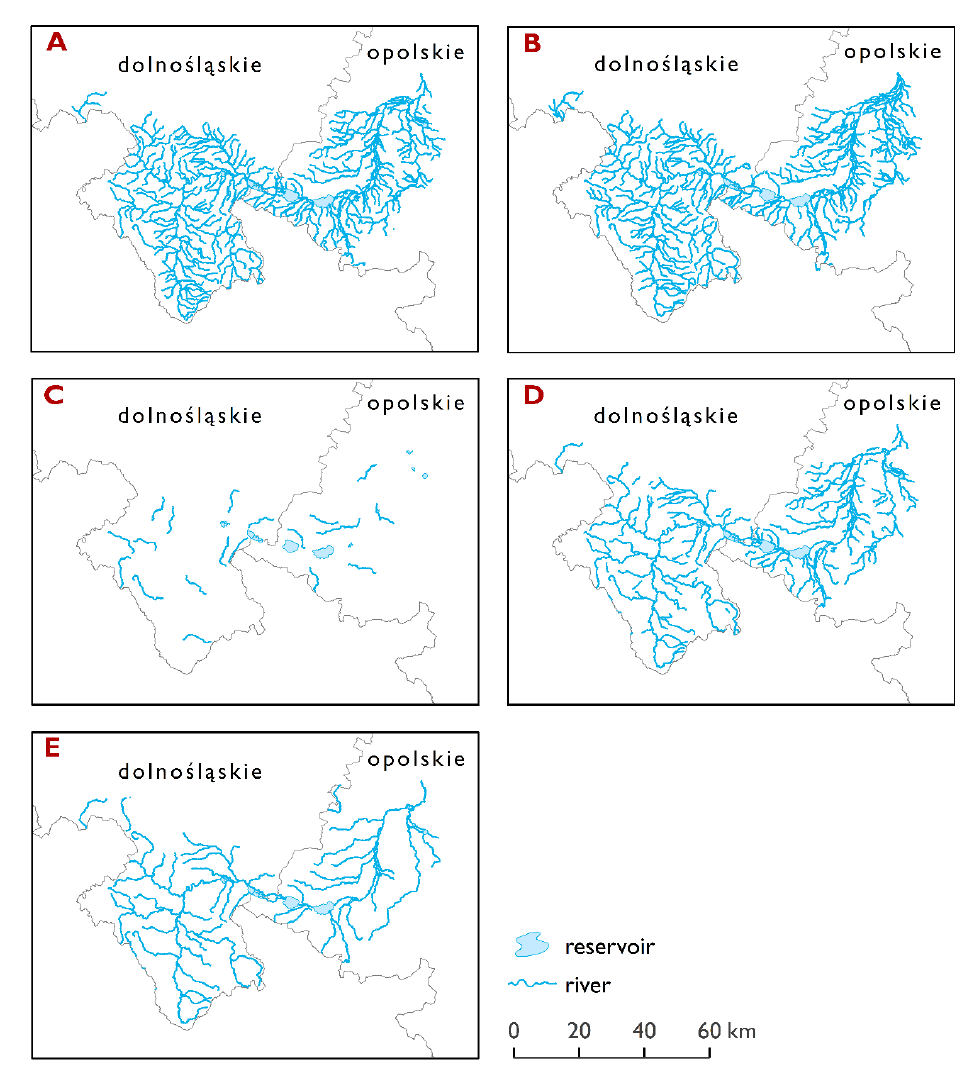
Fig. 8. The results of the generalization of the Nysa Kłodzka basin. A – source data, B – vectorized data from the reference atlas map, C – selection according to the regulation, D – selection according to the regulation using the idMPHP index, E – selection according to the regulation with the use of